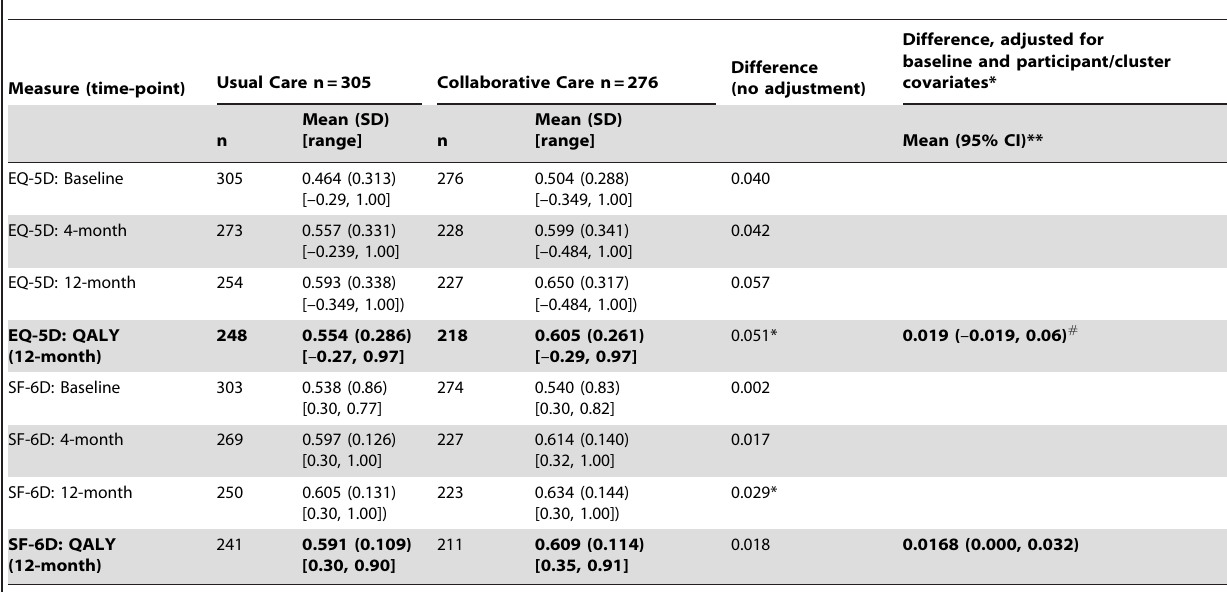
Table 5. Health State Values and QALY comparisons (adjusted, unadjusted), over 12-month follow-up, by group.